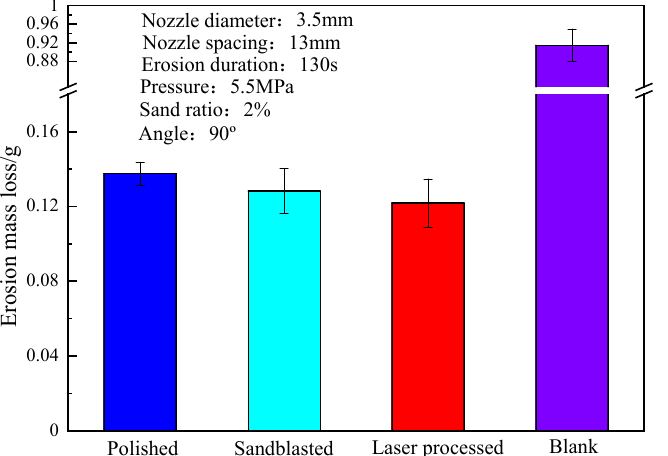
Figure 6. Erosion mass loss histogram of WC coating coupons under different pretreatments. Figure 7. Erosion topography of polishing coating. ( a ) morphology of substrate. ( b ) morphology of coating erosion